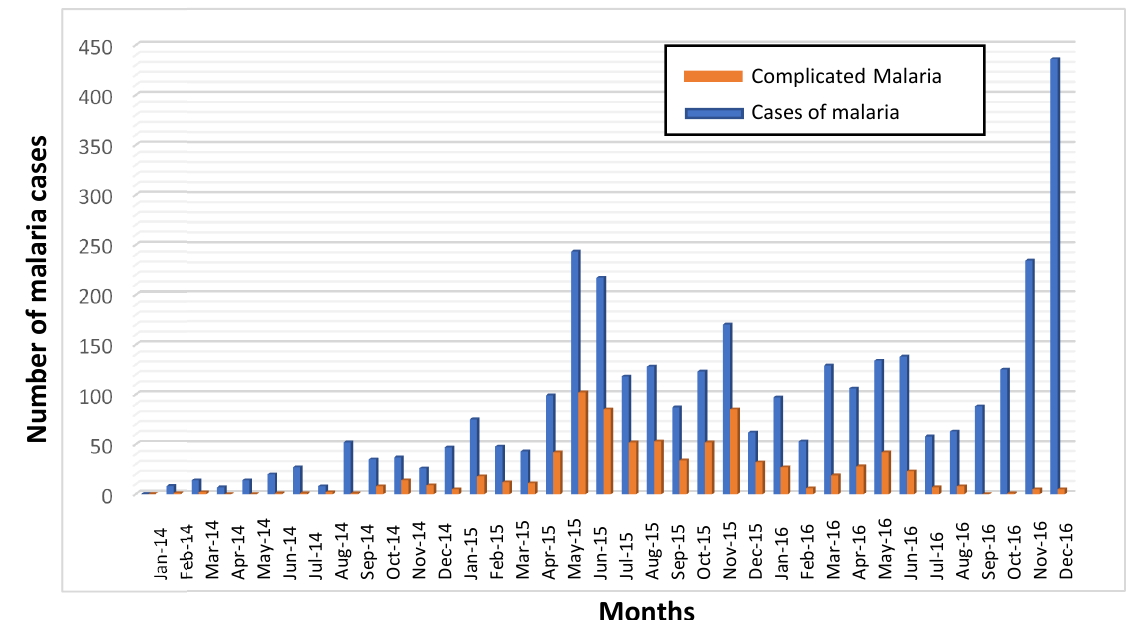
Figure 3. Absolute number of monthly cases of malaria (blue columns) and complicated malaria (orange columns) in Cubal, 2014–2016.